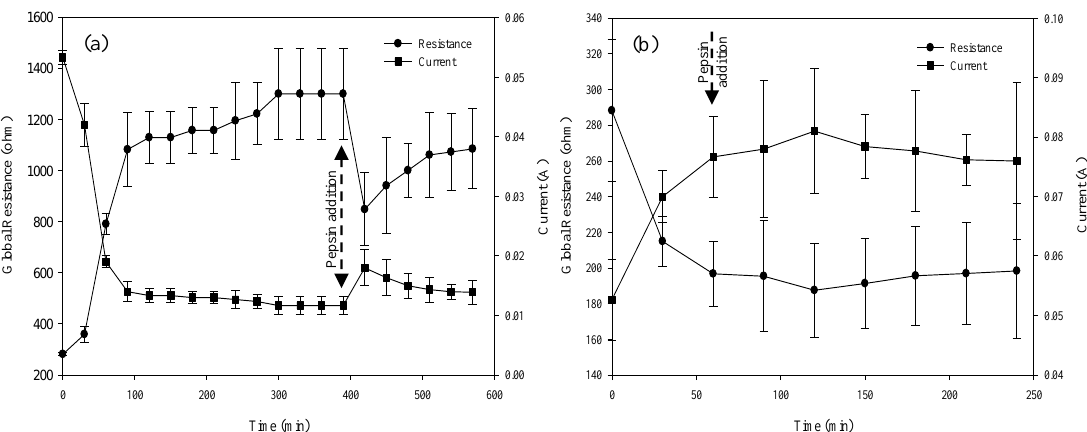
Figure4. Evolutionofthesystemglobalresistanceandcurrentasafunctionoftimeduringelectrodialysis Figure 4. Evolution of the system global resistance and current as a function of time during process in EDBM-MCP ( a ) and in EDBM-AEM ( b electrodialysis process in EDBM-MCP ( a ) and in EDBM-AEM ( b ).